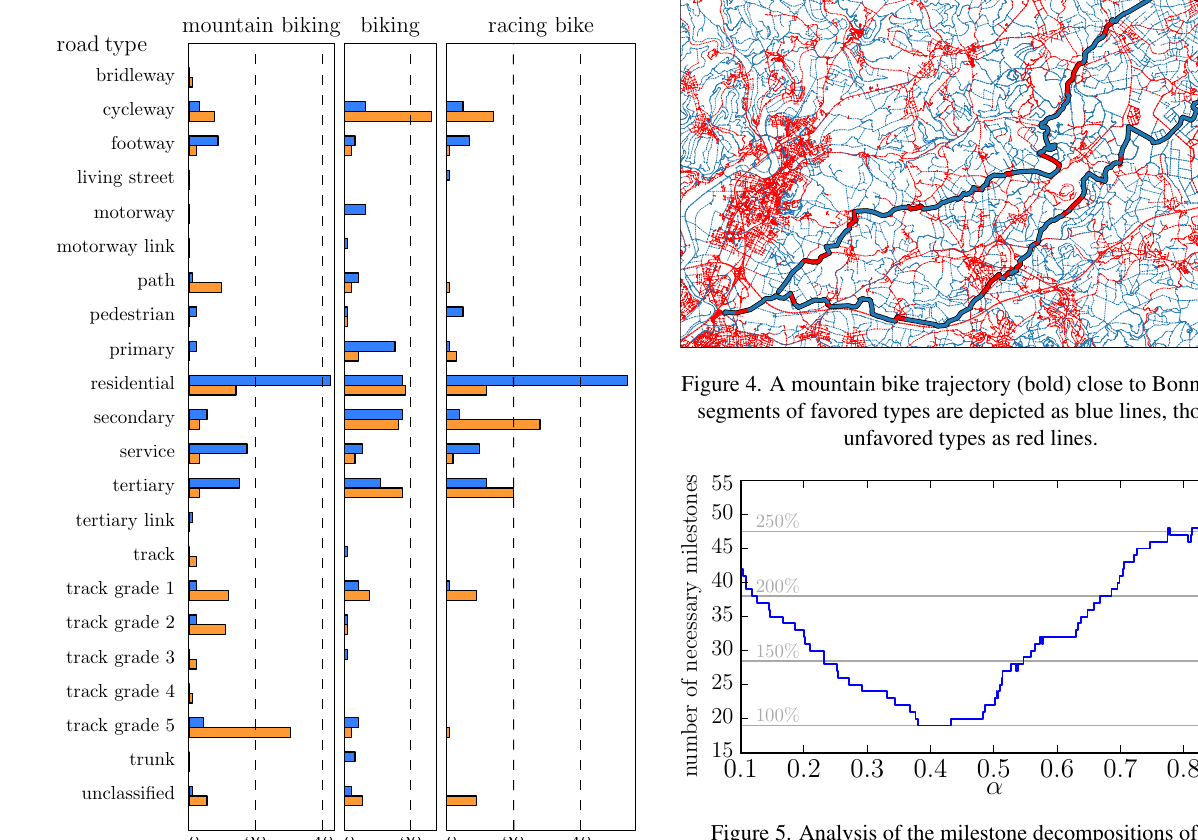
Figure 5. Analysis of the milestone decompositions of the trajectory given in Fig.